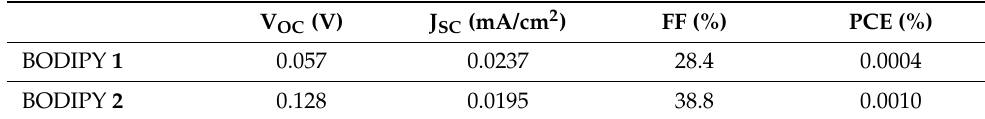
Table 4. Photovoltaic performance of the best-realized BODIPY 1 and 2 devices with the water-based electrolyte. V OC (V) J SC (mA/cm 2 ) FF (%) PCE (%) BODIPY